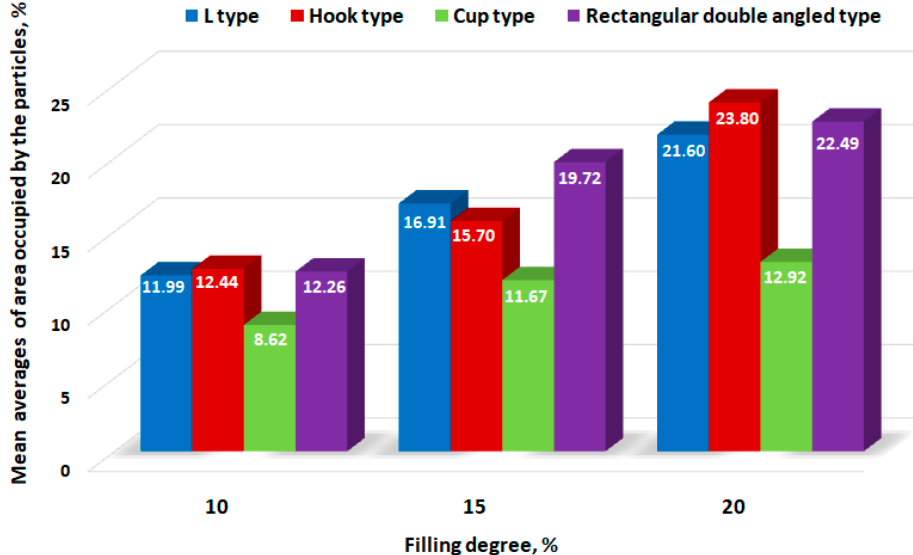
Figure 10. The influence of flight shape on the dispersion degree of the particle for different drum filling degrees.